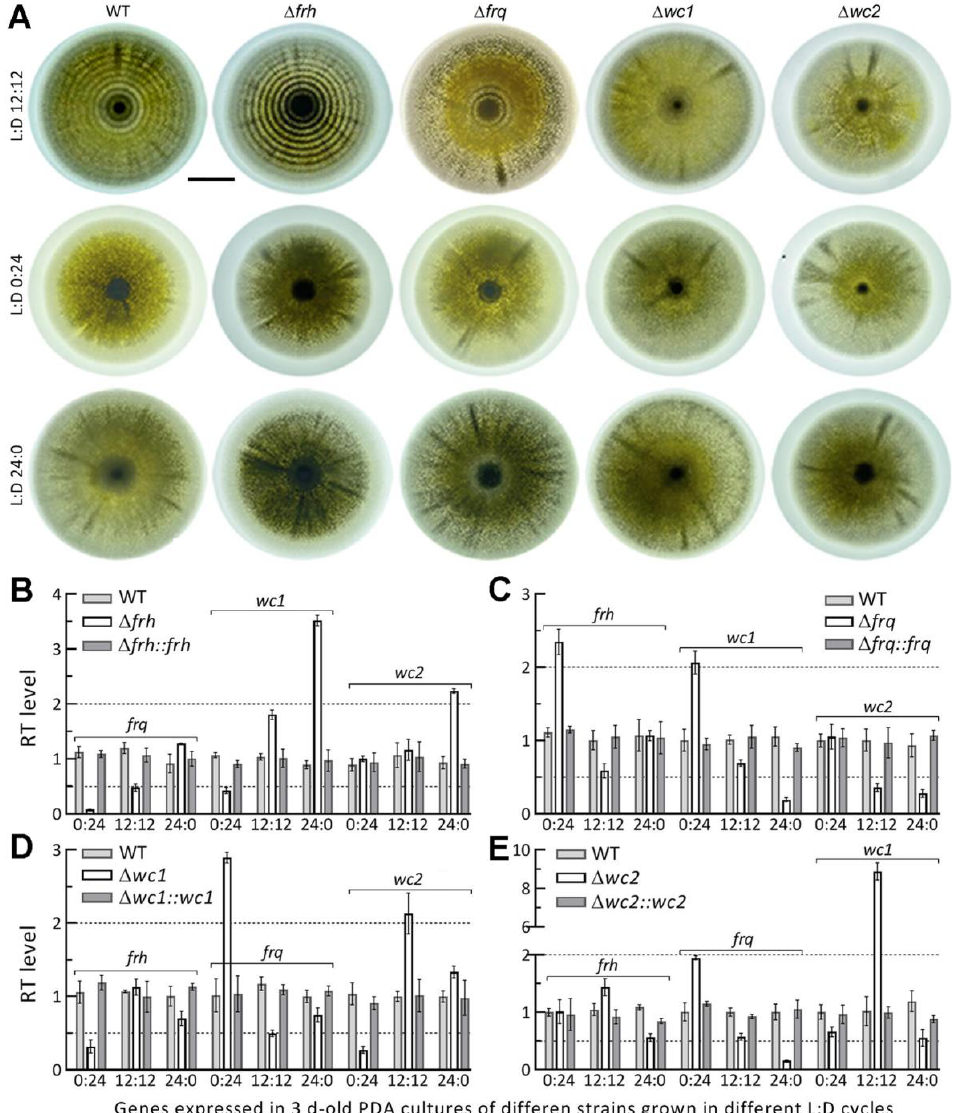
Figure 4. Impacts of knockout mutations on the circadian rhythm of M. robertsii . ( A ) Images (scale bar: 10 mm) for thecircadian rhythm shown (in a film visualization system) in the 15 d-old PDA cultures of the WT, Δ frh , Δ frq , Δ wc1, and Δ wc2 strains incubated at 25 °C in the indicated L:D cycles. ( B – E ) Effects of frh , frq , wc1, or wc2 deletion on relative transcript (RT) levels of the three other genes in the 3 d-old PDA cultures in the L:D cycles. Upper and lower dashed lines denote one-fold up- and down-regulation versus the WT strain. Error bars: SDs from three independent cDNA samples.